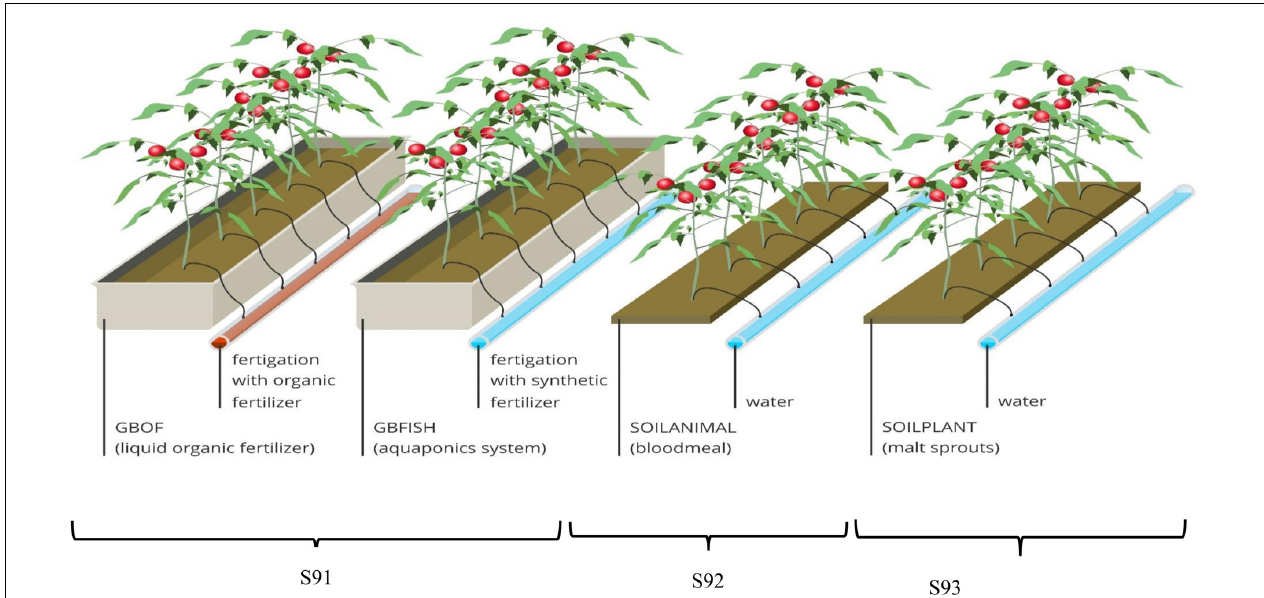
FIGURE 1 | Overview of the experimental set-up showing one experimental unit per treatment. The glass house was divided into three compartments (S91, S92, and S93) with a surface of 80 m 2 for each compartment. The compartment for the soilless culture system (S91) was subdivided into two part. i.e., GBOF and GBFISH; S92 was organic soil fertilized with animal (blood meal) derived material and S92 was the organic soil fertilized with plant-derived material (malt sprouts). In S92 and S93 the previous cultures were tomato in 2014, pepper in 2013 and cucumber in 2012. Plant density was the same for all the treatment 2.65 plants m - 2 . For the soilless culture system and soil-based system five experimental units were randomly selected from the different